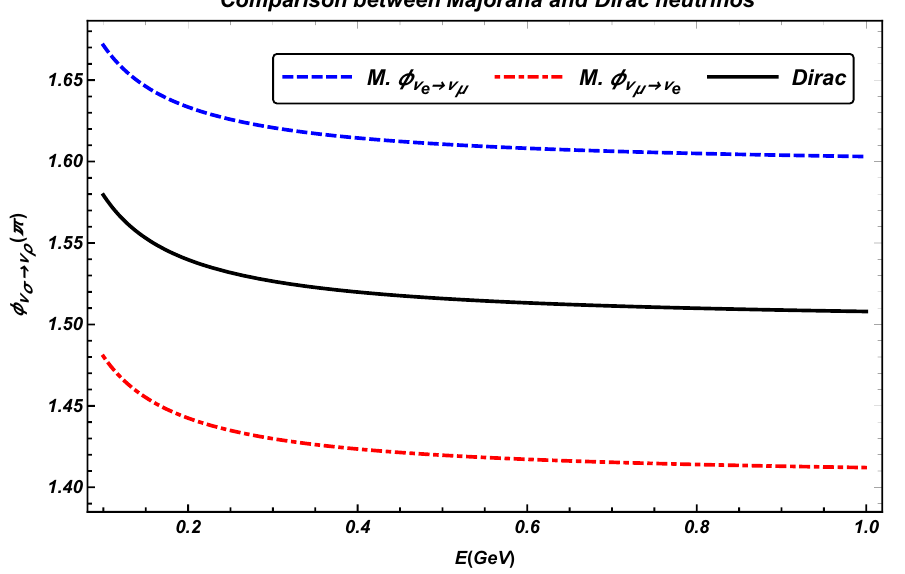
Figure 2. (Color online) Plot of the geometric phases Φ g ν dot dashed line) for Majorana neutrinos as a function of the neutrino energy E , for a distance length z = 300 km. The geometric phases Φ g ν solid